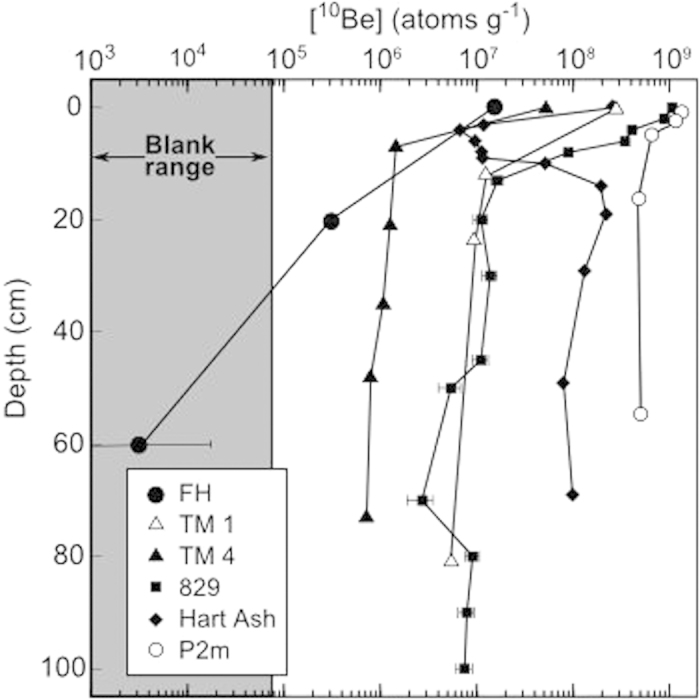
Meteoric [10Be] measured in shallow Dry Valleys sediments: FH (Friis Hills, this study’s Pit 1); TM 1, TM 4 (corrected for in-situ10Be contamination)18; 82920; Hart Ash (and its underlying paleosol)21; P2m22.Gray shading indicates measured [10Be] and associated error in the chemical blank. Results from Pit 2 register [10Be] <0 atoms g−1 and, as such, cannot be plotted on log scale.